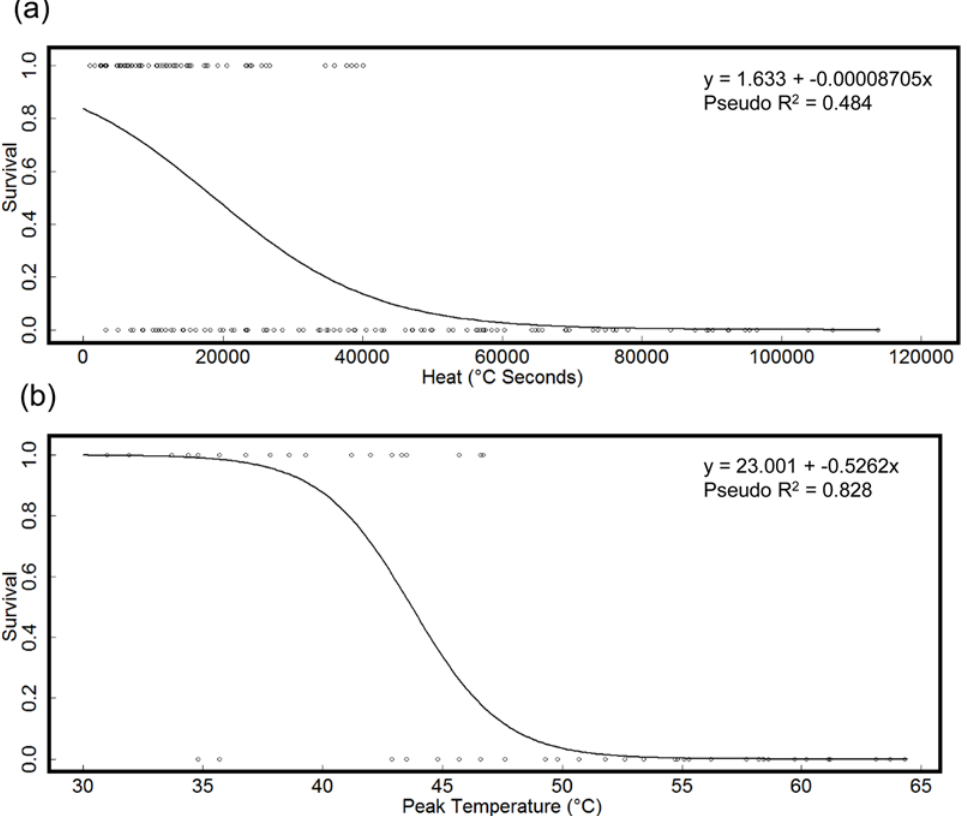
Fig 7. Probability of survival of E . atala pupae following water bath immersion. Plot of probability of survival of E . atala pupae to successful adult eclosion as a function of heat (A) and peak temperature (B) from the laboratory water bath experiment, February, 2012. Nagelkurke/Cragg & Uhler ’ s pseudo R 2 included as measure of model